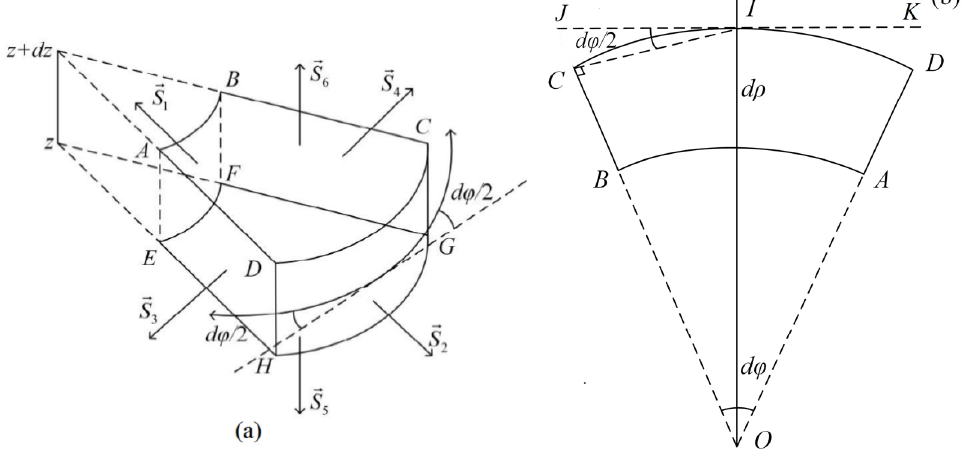
Figure 2. Schematic diagram of stresses on the microvolume element. ( a ) Stereogram; ( b ) Top view. As shown in Figure 2, the microvolume element is affected by four stresses in the → S 1 ), there is a geometrical angle tangential direction ( ϕ ) of the transducer. On the surface ( ( d ϕ /2) between the dotted-line segment ( JK ) and the T ρϕ shear stress; the same angle ( d ϕ /2) also holds between the dotted-line segment ( JK ) and the physical stresses on the other five surfaces. So, the resultant force in the tangential direction